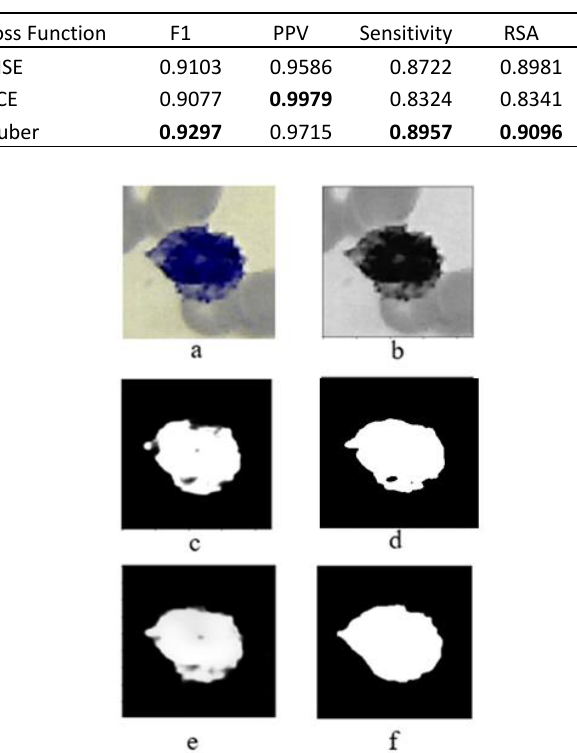
Table 2. Testing result comparison